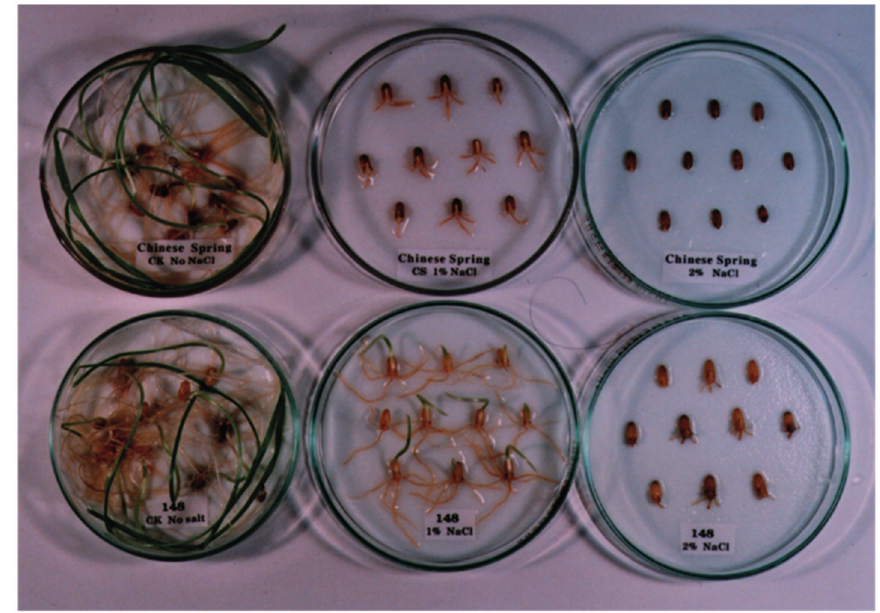
Figure 1. Salt tolerance test of Chinese Spring ( above ) and S148 ( below ) at the germination stage. A, B, and C: NaCl conc. 0.0, 0.2 and 0.4 M, respectively.